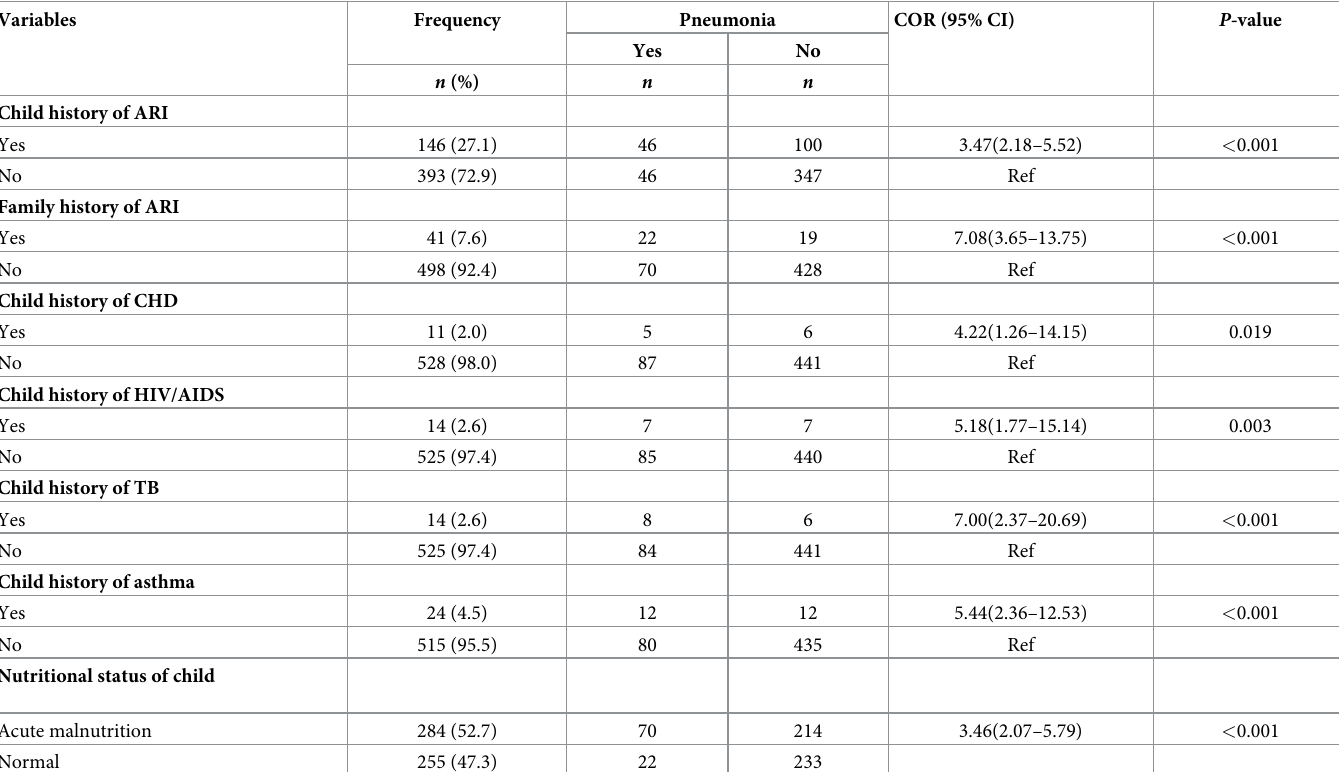
Table 4. Bivariate analysis of the association of pre-existing medical conditions with pneumonia among children under five in peri-urban areas of Dessie City, north-eastern Ethiopia, January—March 2019. Variables